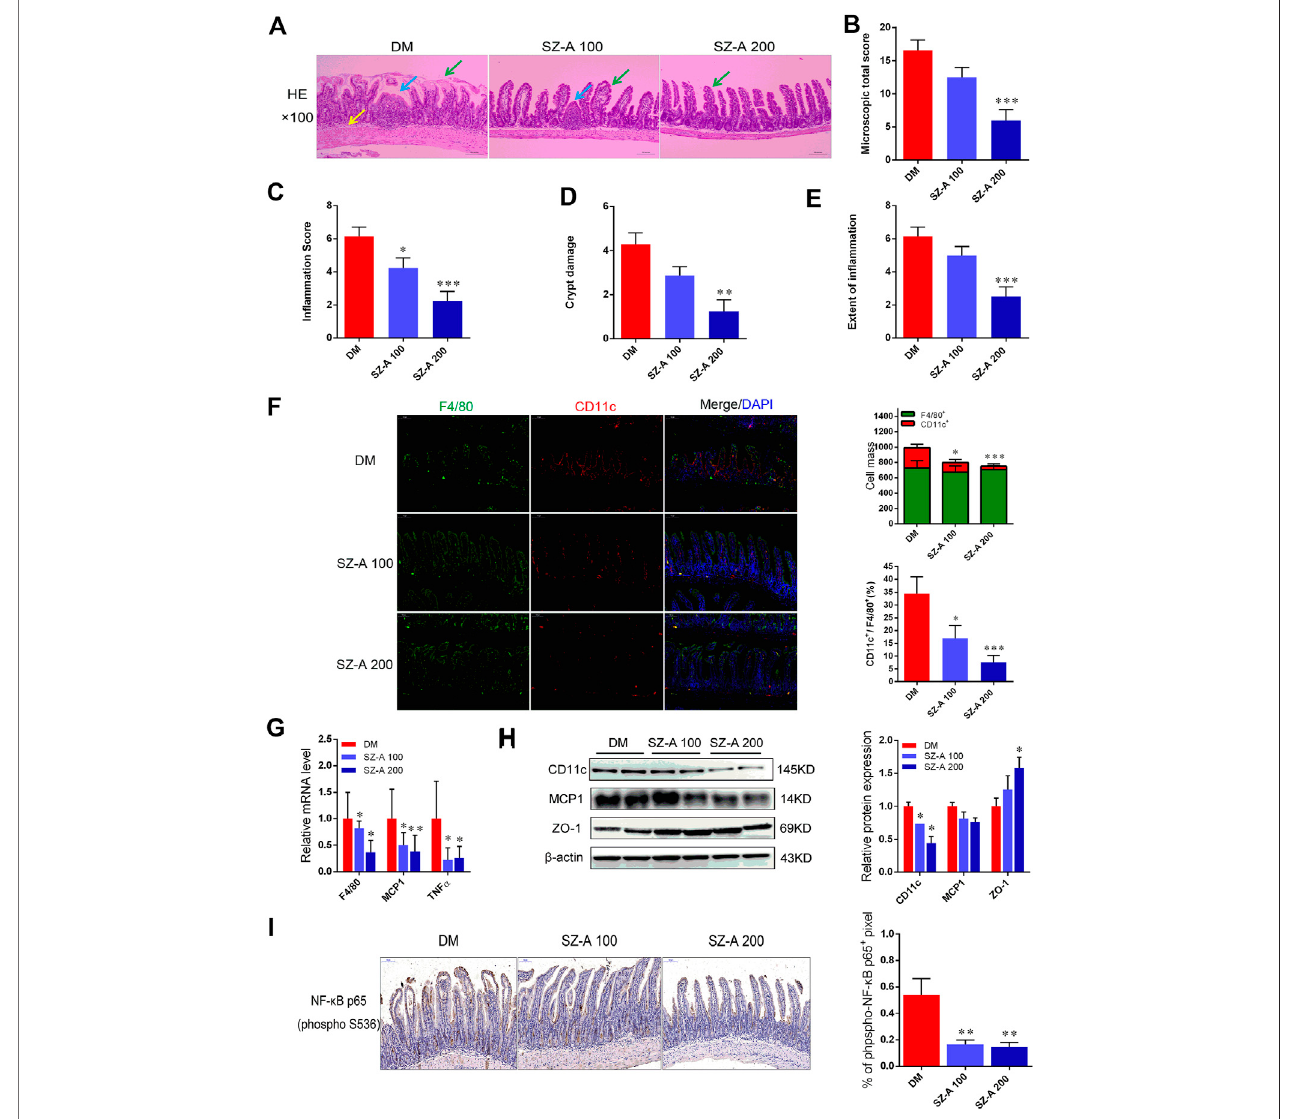
FIGURE4| SZ-A alleviates ilealin fl ammatoryinjuryand pro-in fl ammatory macrophagein fi ltration inKKAy mice. (A) RepresentativeH&E stainingofthe ilealsection (scalebar,200 µm). (B) Histopathologicalassessmentoftotalscore. (C) In fl ammationscore. (D) Cryptdamagesscore. (E) Extentofin fl ammationscoreofilealsections. (F) RepresentativeF4/80(green), CD11c(red) and DAPI (blue) immuno fl uorescence staining ofileum tissues (Scale bar, 100 µm). The histograms indicate quanti fi cation ofF4/80(F4/80 + )orCD11c(CD11c + )positivecellsper fi eldandpercentagesofCD11cpositivecellsinmacrophages(F4/80 + )(n (cid:1) 5pergroup). (G) Real-timePCR analysis of F4/80, MCP1 and TNF- α levels in ileal homogenates ( n (cid:1) 5 per group). (H) CD11c, MCP1 and ZO-1 protein abundant levels. The blots shown were representative images. (I) Sections of the ileum were stained with anti-NF- κ B p65 (p-S536), the histograms indicate quanti fi cation of p-NF- κ B p65 positive area per fi eld ( n (cid:1) 5pergroup).Dataweremean ± SEM,* p < 0.05,** p < 0.01,*** p < 0.001 vs .DM.DM,diabeticmodelgroup,SZ-A100,SZ-Alow-dose-treatedgroup,SZ-A200,SZ- A-high-dose-treated group.